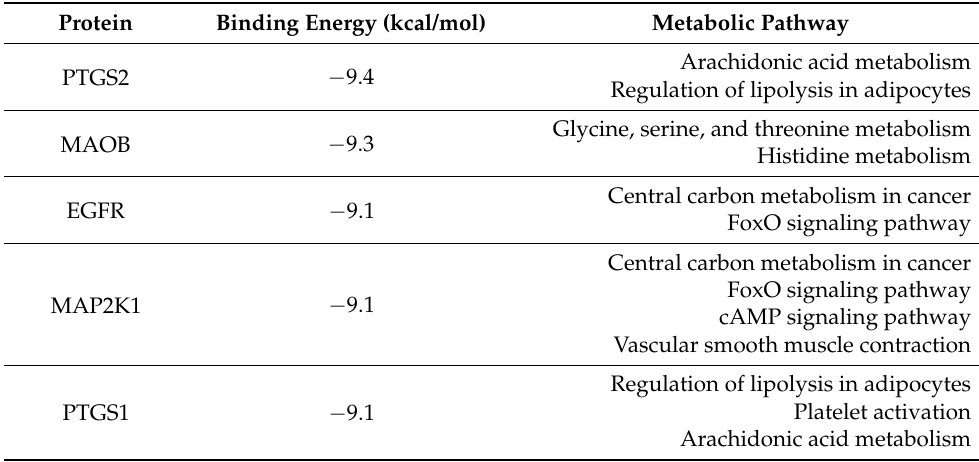
Figure 7. Schematic docking diagram of top five binding energy proteins. ( A ) PTGS2; ( B ) MAOB; ( C ) EGFR; ( D ) MAP2K1; and ( E ) PTSG1. Table 4. Top five binding energy proteins and metabolic